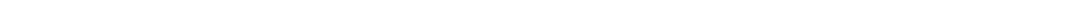
(see fi gure on previous page) Fig. 6 Inhibition of ROS decreases cellular senescence of Ndufs6 − / − -BM-MSCs. A The mitochondrial ROS of Ndufs6 − / − -BM-MSCs and Mito- TEMPO-treated Ndufs6 − / − -BM-MSCs was measured by Mito-Sox staining. B The mitochondrial ROS of Ndufs6 − / − -BM-MSCs and Mito-TEMPO-treated Ndufs6 − / − -BM-MSCs was statistically quanti fi ed. C SA- β -gal staining showing β -gal-positive cells in Ndufs6 − / − -BM-MSCs and Mito-TEMPO-treated Ndufs6 − / − -BM-MSCs. D The β -gal positivity in Ndufs6 − / − -BM-MSCs and Mito-TEMPO-treated Ndufs6 − / − -BM-MSCs was quanti fi ed by calculating the ratio of stained cells to total cells. E The proliferation of Ndufs6 − / − -BM-MSCs and Mito-TEMPO-treated Ndufs6 − / − -BM-MSCs was assessed by Ki-67 staining. F The Ki-67 positivity in Ndufs6 − / − -BM-MSCs and Mito-TEMPO-treated Ndufs6 − / − -BM-MSCs was quanti fi ed by calculating the ratio of stained cells to total cells. G The mRNA level of p53 and p21 was assessed in Ndufs6 − / − -BM-MSCs and Mito-TEMPO-treated Ndufs6 − / − -BM-MSCs. H The protein level of p53 and p21 was assessed in Ndufs6 − / − -BM-MSCs and Mito-TEMPO-treated Ndufs6 − / − -BM-MSCs. Results are presented as mean ± SD. n = 3. **p <